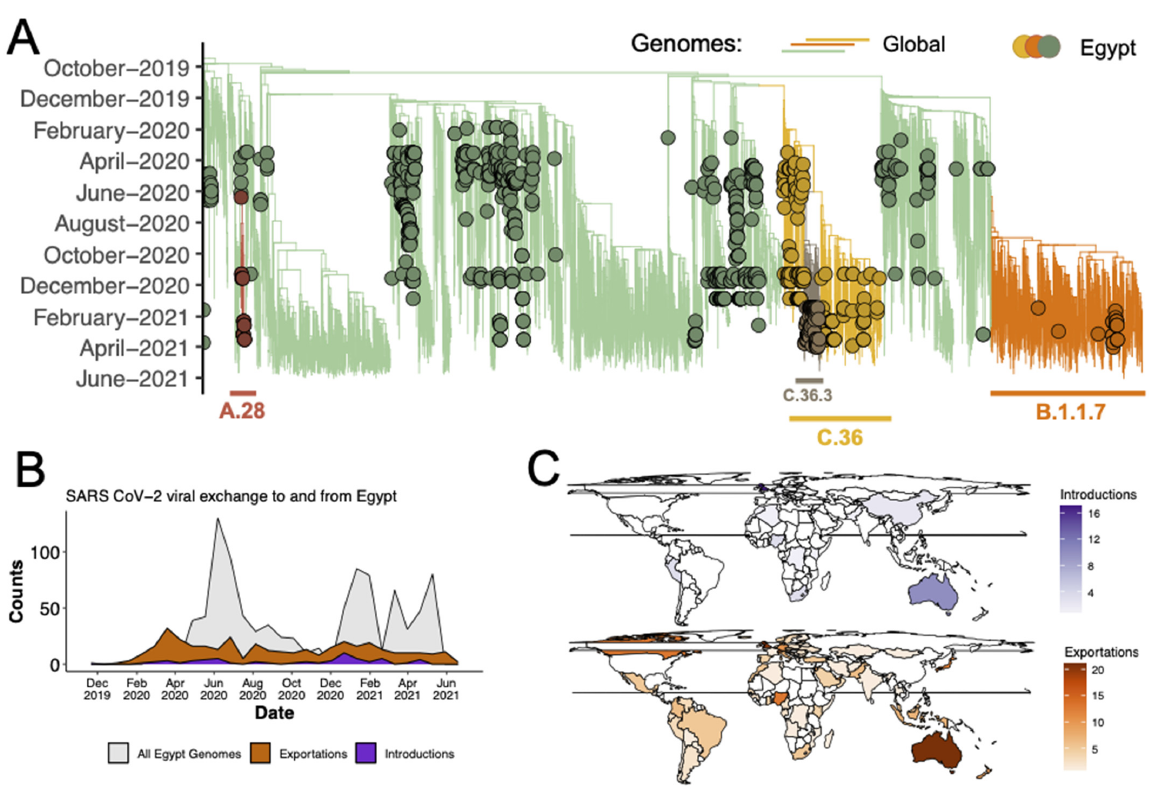
Figure 2. Phylogenetic reconstruction of the SARS-CoV-2 epidemic in Egypt. ( A ) Time-resolved maximum clade credibility phylogeny of the major lineages circulating in Egypt. ( B ) Area plot showing viral import-export as proportions of the sampled genomes. ( C ) Inferred locations of imports into and exports of SARS-CoV-2 out of Egypt. Sampling for molecular and genomic analyses across Egypt were sporadic across 2020 and 2021. Although genomic sequencing only detected C.36/C.36.3 in Cairo (GISAID Metadata), qPCR assays were able to detect these lineages in various other locations (Figure 3B) at a high proportion of the total numbers of samples tested with the qPCR assay (Figure